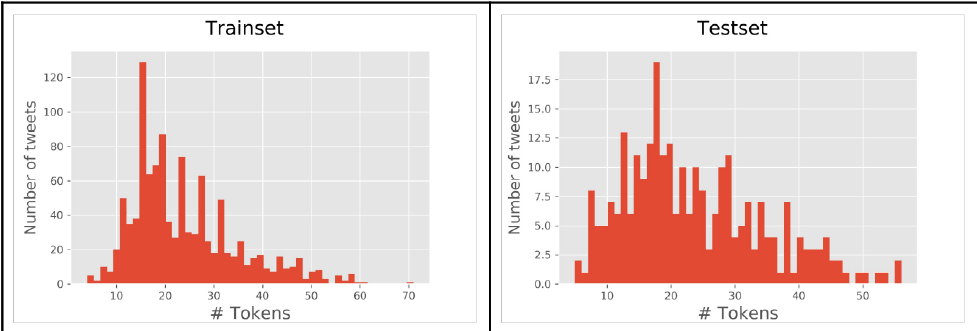
Figure 4. Distribution of number of tokens per number of